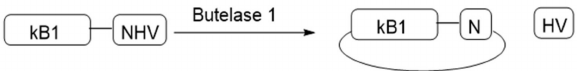
Figure 12. Schematic of butelase 1 catalyzed cyclization. kB1 containing 29 amino acid residues is the core peptide of plant cyclotide kalata B1. Asp-His-Val (NHV) is the C-terminal sequence recognized by butelase 1. Adapted from Reference [39].